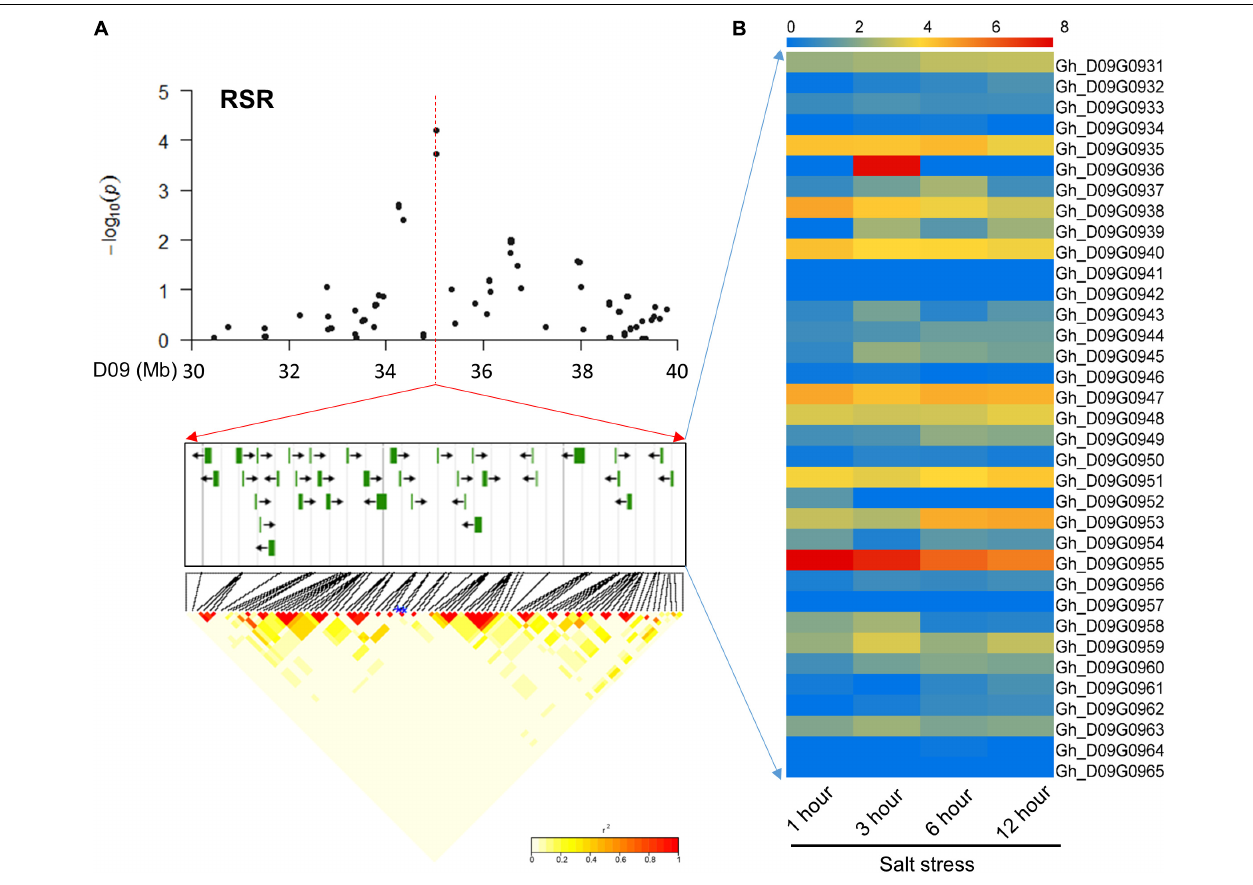
FIGURE 3 | Identification of the candidate genes for RSR and STL on the peak of chromosome D09. (A) Local Manhattan plot (top) and LD heatmap (bottom) surrounding the peak. The 35 candidate genes were presented in the middle. (B) Heat map of the expression of the 35 candidate genes at four time points. The samples were collected at 1, 3, 6, and 12 h under salt